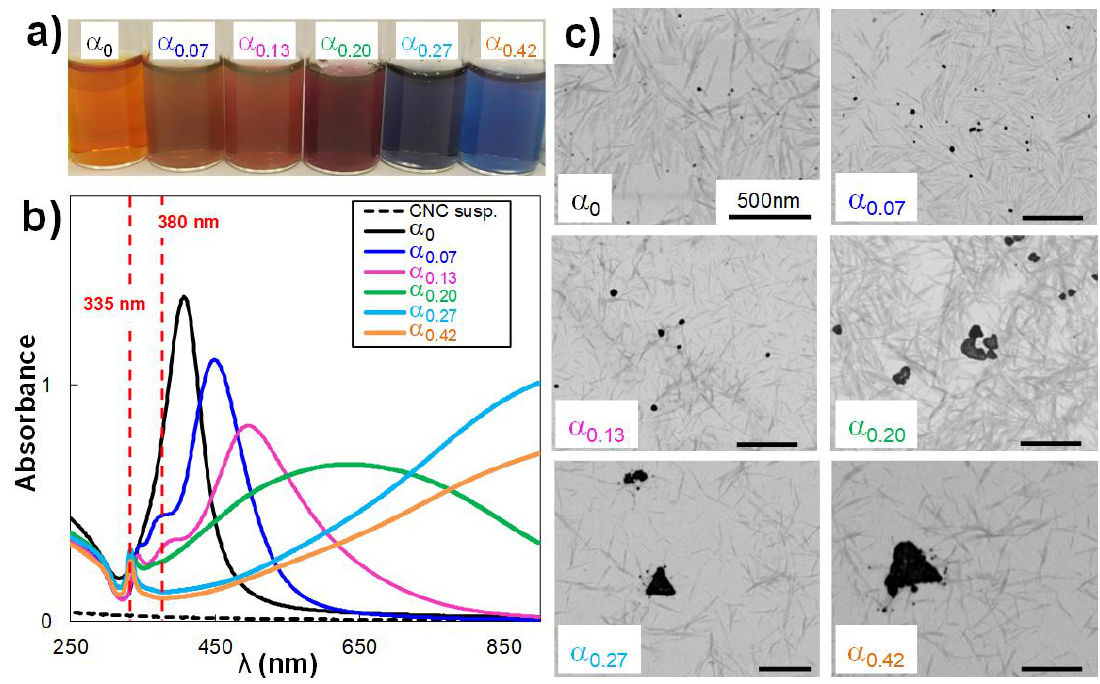
Figure 1. ( a ) color evolution; ( b ) UV-Vis spectra; and ( c ) corresponding scanning transmission electron microscopy (STEM) images of cellulose nanocrystal (CNC) / silver nanoparticle (AgNP) hybrid suspensions at 8.7 wt% AgNP treated with various H 2 O 2 volumes (i.e., variation of H 2 O 2 / AgNP mass ratio, α ). In STEM images, bar scales of 500 nm are indicated.